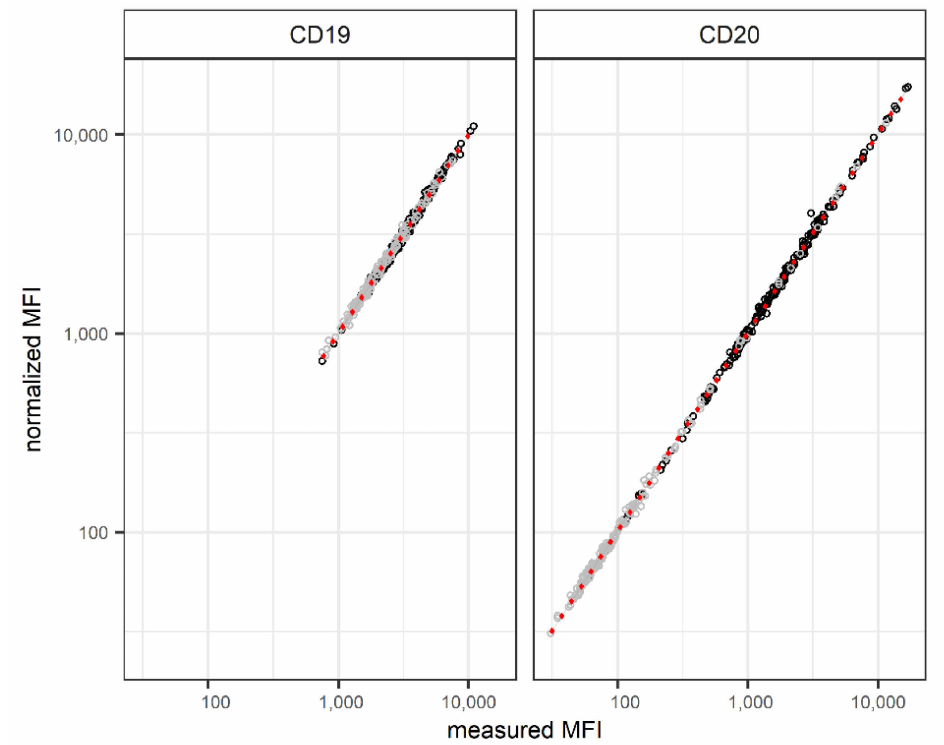
Figure 4. Correlation plot of measured and normalized MFIs for CD19-PerCP Cy5.5 and CD20-FITC in 196 samples prior to therapy (black) and 166 on-therapy (grey) samples from 196 patients enrolled in the CLL2-BXX trials. Linear regression (red) is close to 1 (R 2 CD19: 0.997; R 2 CD20: 0.999), as NF used for normalization was between 0.9 and